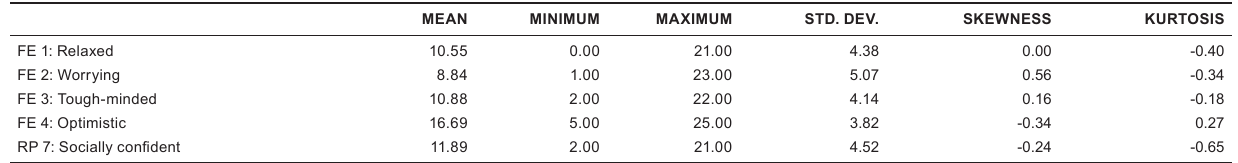
TABLE 2 Descriptive statistics of the dependent variable, Stress Management (n = 105) MEAN MINIMuM MAxIMuM STD. DEv.